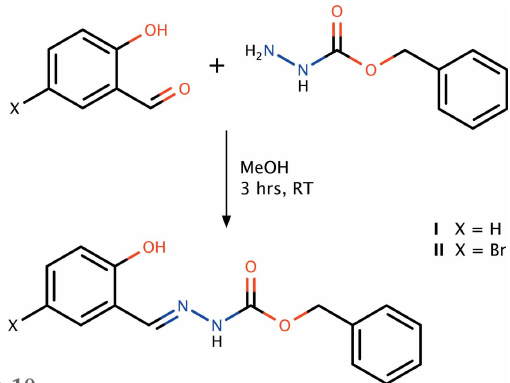
Figure 10 Reaction scheme for the synthesis of I and II